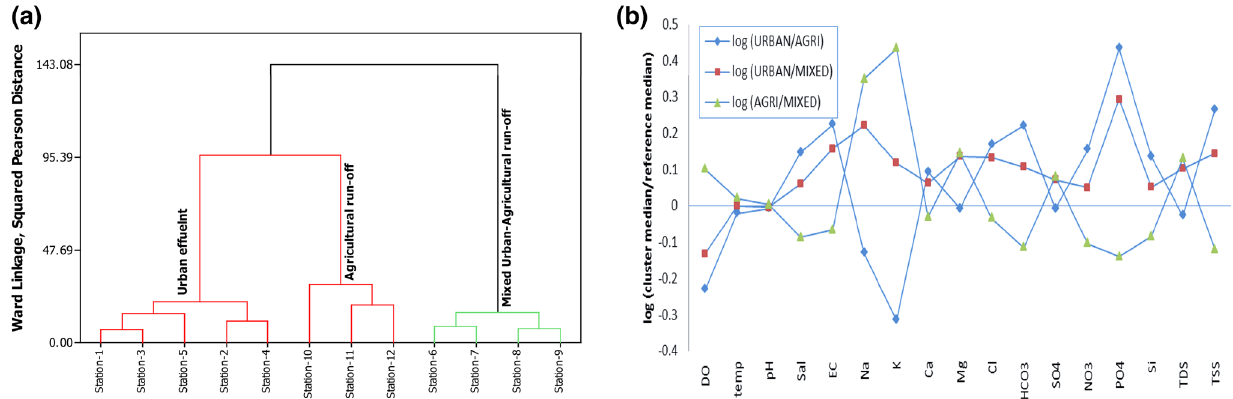
Fig. 8 Land use signature in Mayur river water: a dendrogram pro- duced from hierarchical cluster analysis (HCA) showing distinct and dominant land use sites; b Spider diagram showing biogeochemical fingerprints (log normalized to different land uses) of anthropogenic